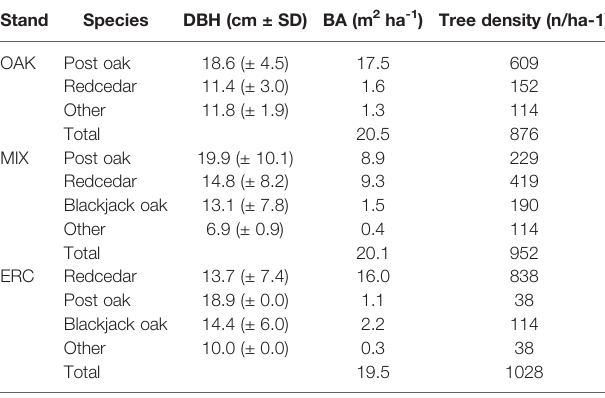
TABLE 1 | Mean diameter at breast height (DBH), basal area (BA), and tree density for each stand for stems greater than 5 cm DBH. Stand